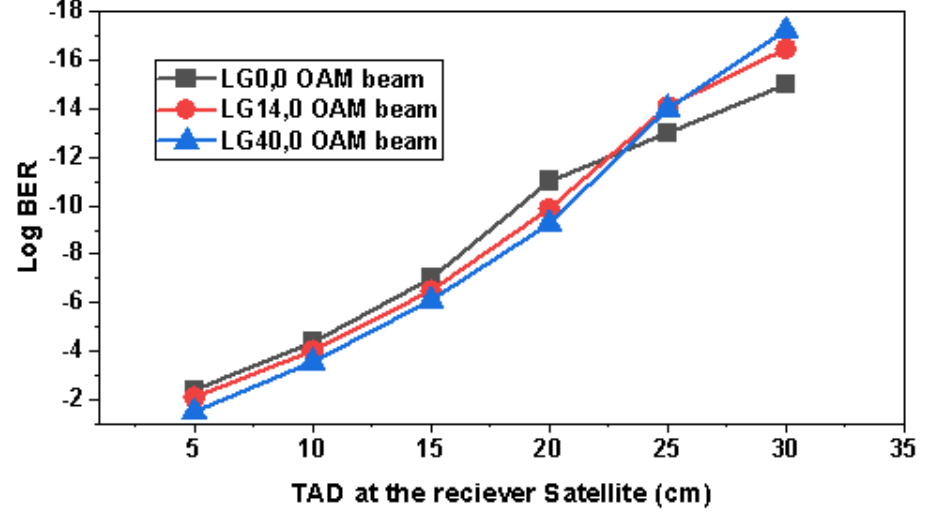
Figure 11. Log BER variation with different TADs at the receiver